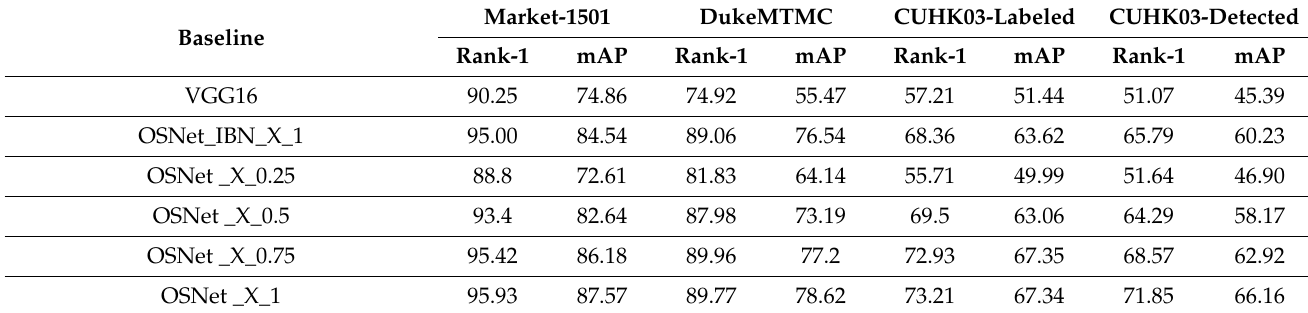
Table 7. Performance of proposed strategy of RE-ID under different baselines.